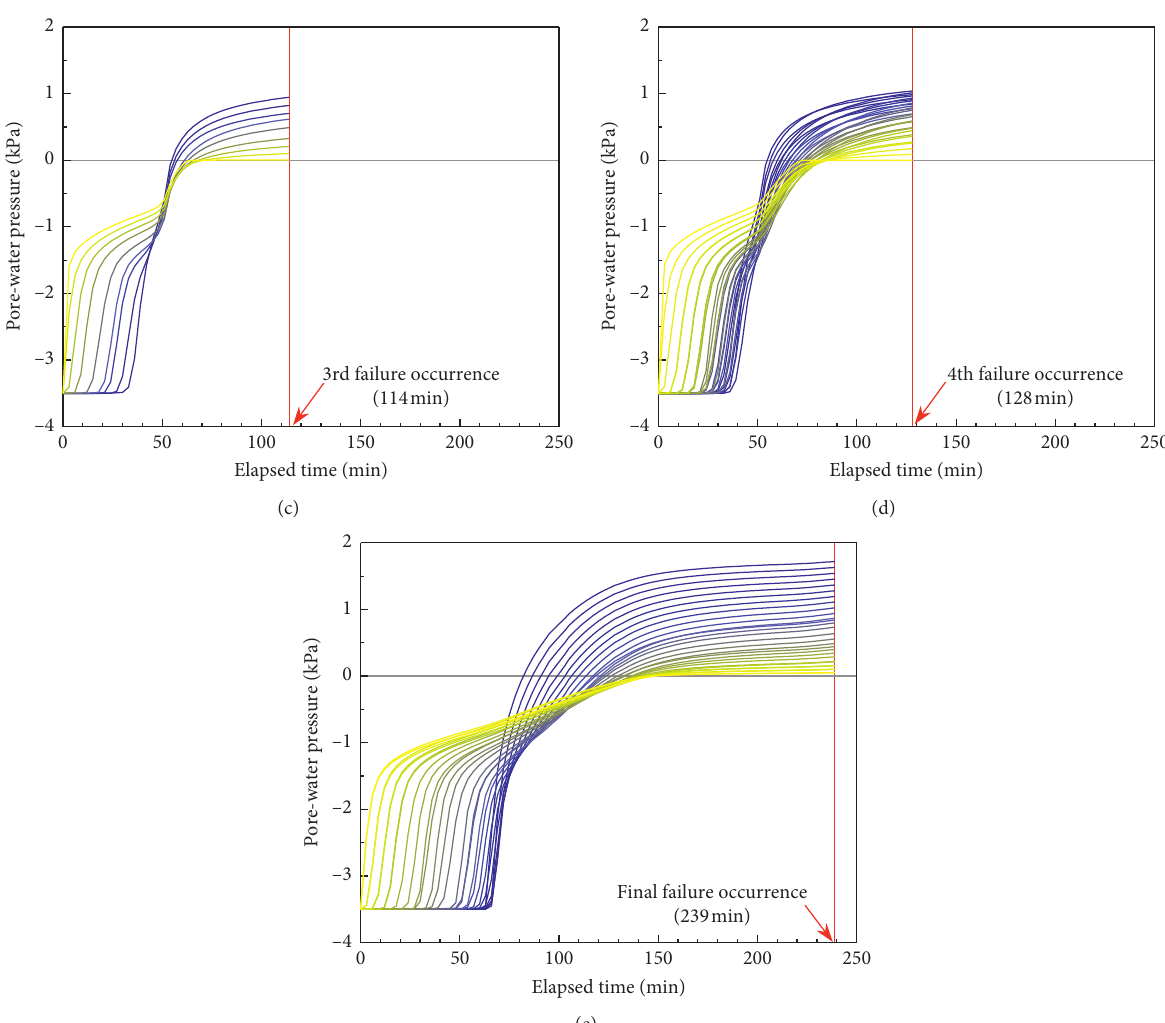
Figure 11: Evolutions of pore-water pressure leading to the five consecutive failures at the nodes corresponding to slip surface locations. ∗ On a color spectrum from blue to yellow, the darkest blue line indicates a node at the lowest elevation, whereas the brightest yellow line indicates a node at the highest elevation. (a) At nodes corresponding to the 1st slip surface. (b) At nodes corresponding to the 2nd slip surface. (c) At nodes corresponding to the 3rd slip surface. (d) At nodes corresponding to the 4th slip surface. (e) At nodes corresponding to the 5th slip